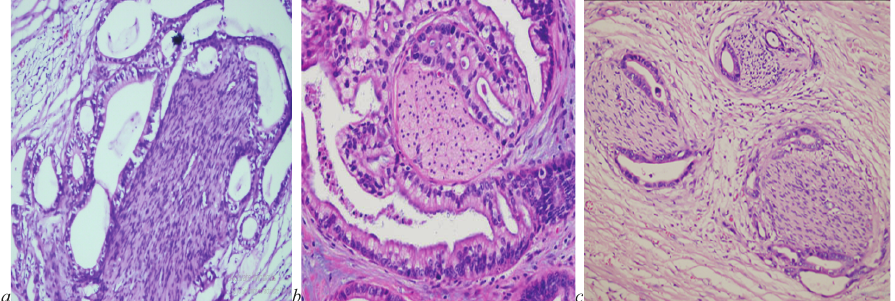
Figure 3 : Peri-neural invasion in periampullary tumors H&E stain × 40.